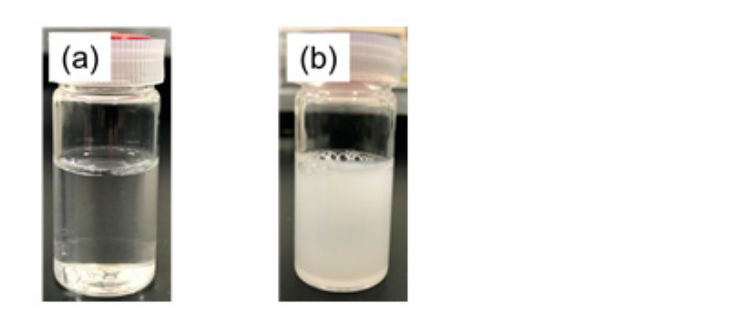
Figure 2. PNIPAM solutions at 25 °C: ( a ) X M = 0; ( b ) X M = 0.20.